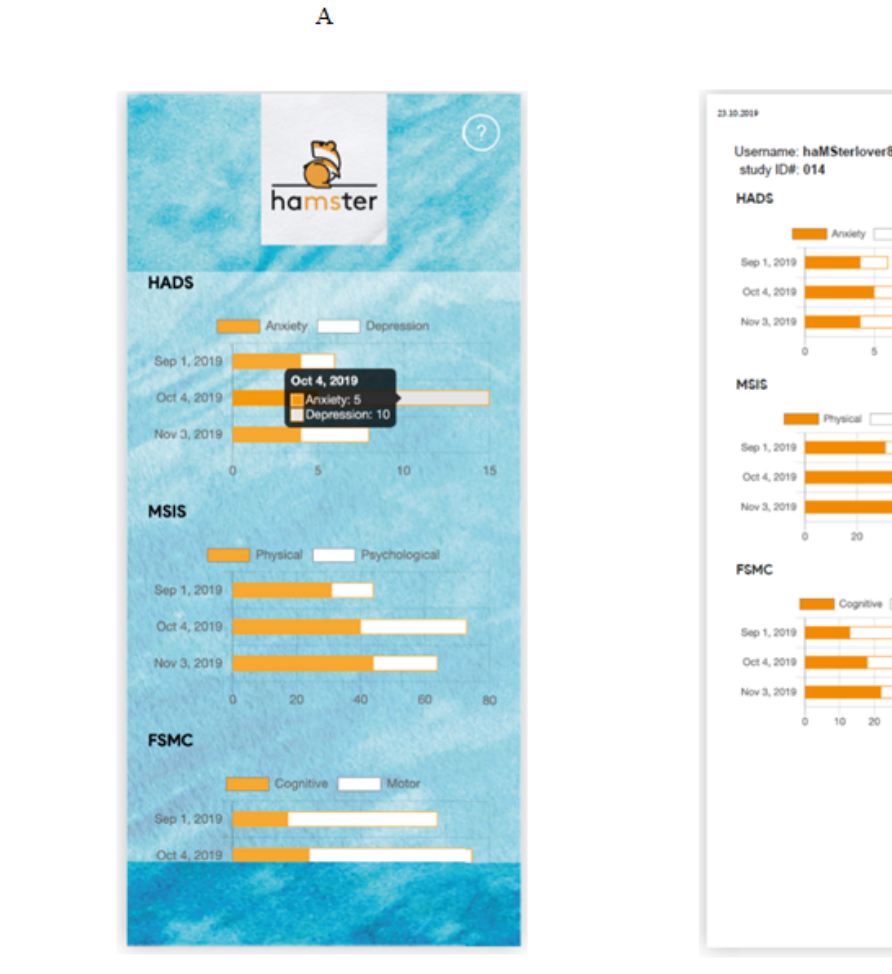
Figure 4. Screenshots of the patient-reported outcome (PRO) scoring information on the smartphone (A) and a printed score sheet (B). The screenshots provided here have been translated from German to English for the purpose of this